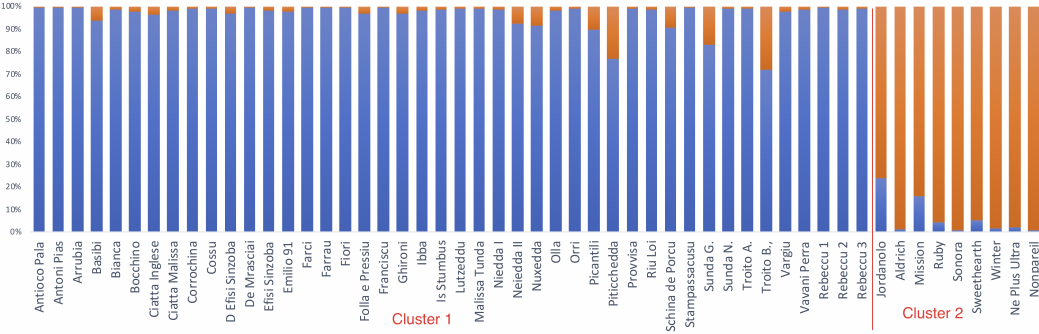
Figure 3. Most probable genetic structure of Sardinian and reference national and international genotypes, as revealed by STRUCTURE analysis. Bars represent individuals, and coefficients of membership (Q) to specific clusters are reported with different colors. Cluster assignment was based on a membership threshold set at >0.75. CL1 (blue), CL2 (red).